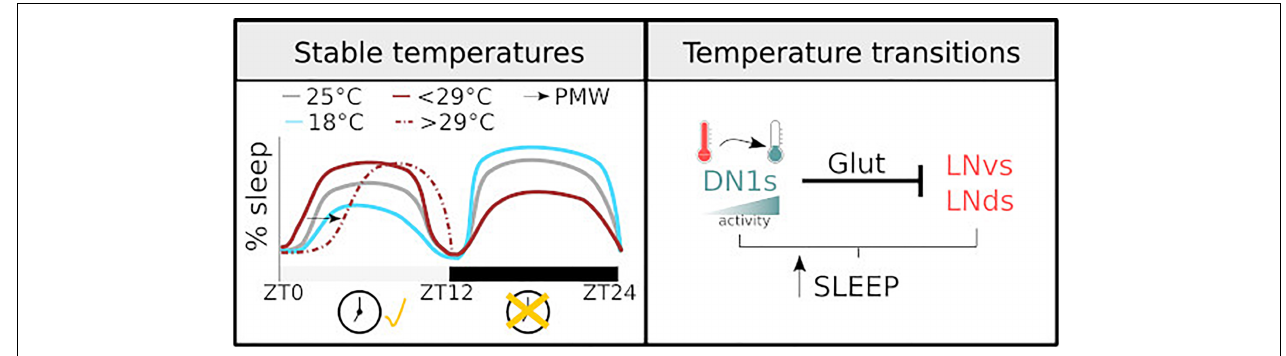
FIGURE 1 | Diagram illustrating how temperature regulates sleep. (Left) The sleep profile of male flies under stable temperatures. The dashed line shows PMW observed with temperature > 29 ◦ C. The changes observed at different temperatures are clock-dependent during the light phase and clock-independent during the dark phase. (Right) the mechanisms of sleep regulation in response to temperature change. The activity of DN1 neurons increases with temperature drops, resulting in an inhibition over the lateral neurons of the circadian clock and sleep promotion.